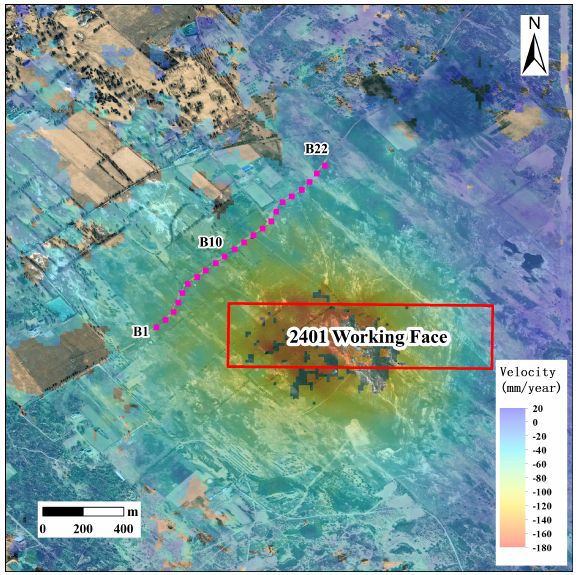
Figure 9. The annual average subsidence rate of the ground surface and the layout of leveling points in the study area. B1–B22 are the point numbers of level measurement points. The layout of the 2401 working face is marked by the red